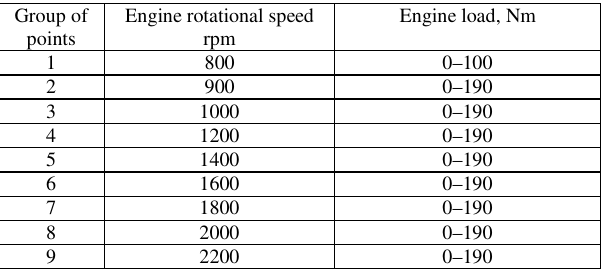
Table 1. Main operating points of the tested engine - research scope Group of points